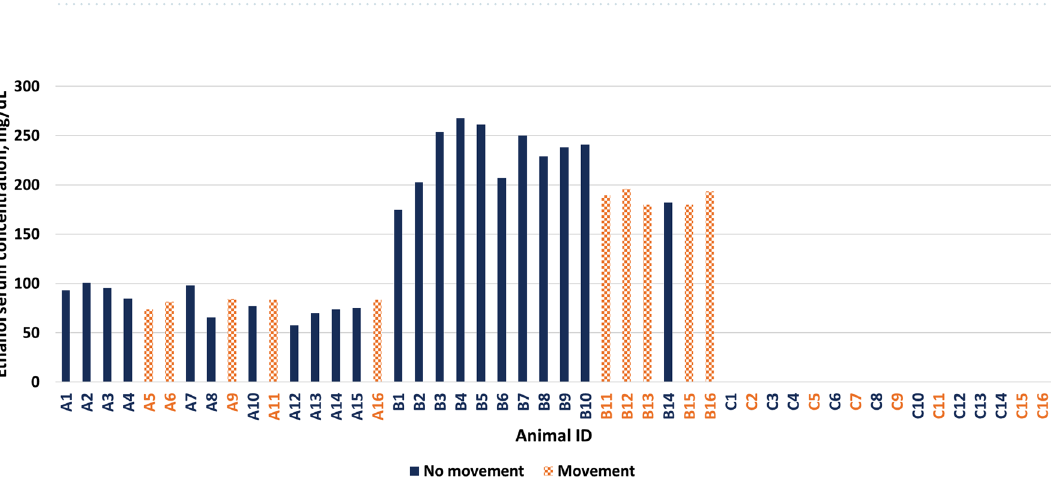
Table 1. Sample estimates and bootstrap estimates of the MAC and the corresponding bootstrap confidence intervals.